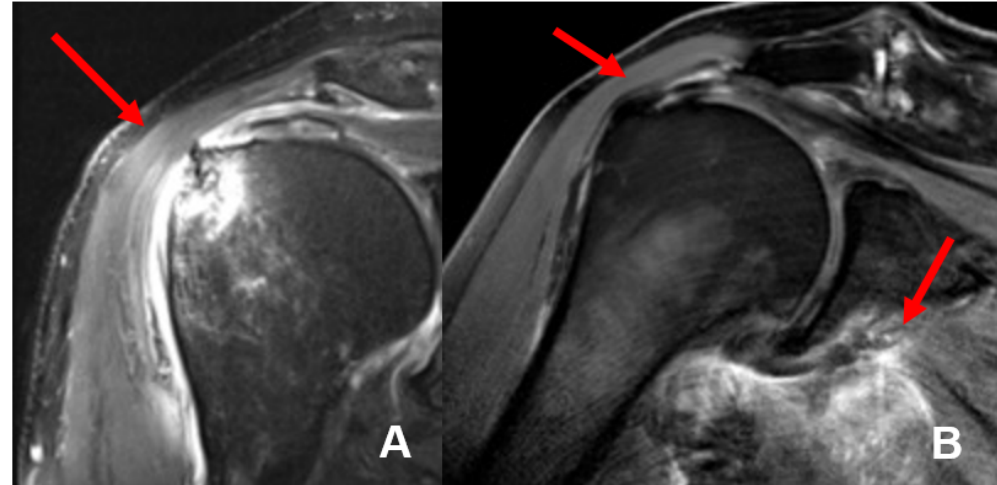
Figure 5. MRI imaging of a complete transmural tear of the supraspinatus tendon ( A ) and complete supraspinatus tendon tear at the foot print with intramuscular hematoma of the musculus subscapularis ( B ) detected in our study.